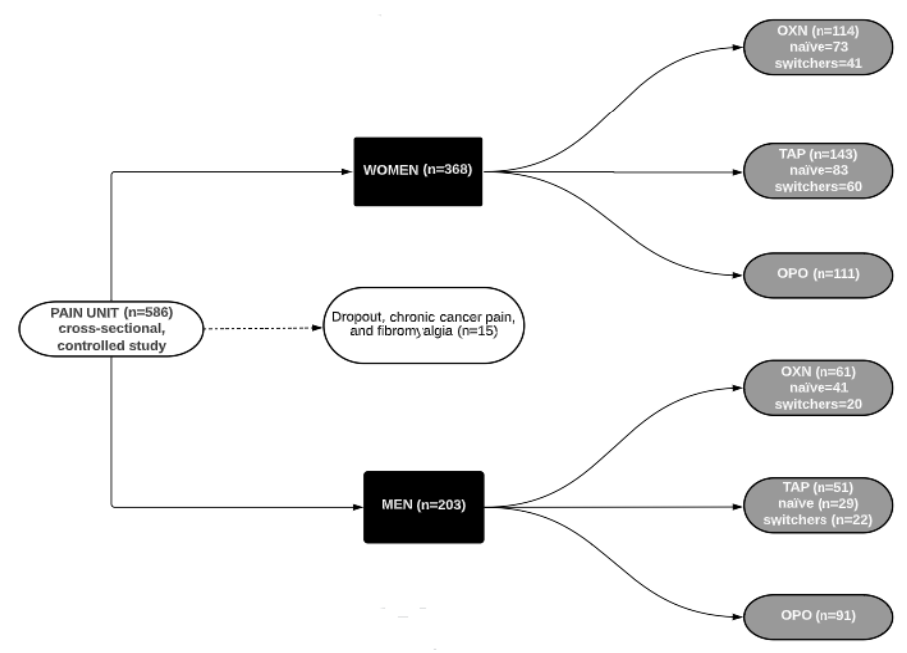
Figure 1. Flow chart of the study.